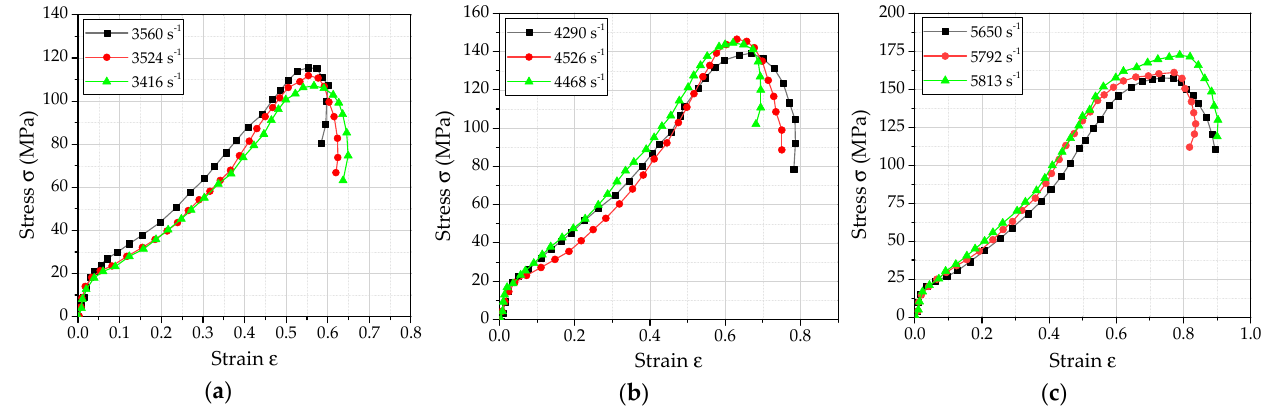
Figure 9. The true stress − strain relationship curve of the PTFE/Al/Si reactive material under differ- ent loading strain rates: ( a ) 3500 s − 1 ; ( b ) 4500 s − 1 ; ( c ) 5500 s − 1 . By analyzing Figure 9, the main dynamic performance parameters of PTFE/Al/Si re- active material at different loading strain rates were obtained as shown in Table 4. In ad- Table 4. The main dynamic performance parameters of PTFE/Al/Si reactive material at different loading strain rates.